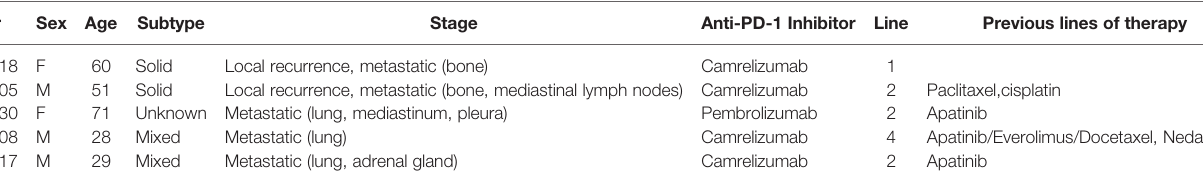
TABLE 3 | Patients ’